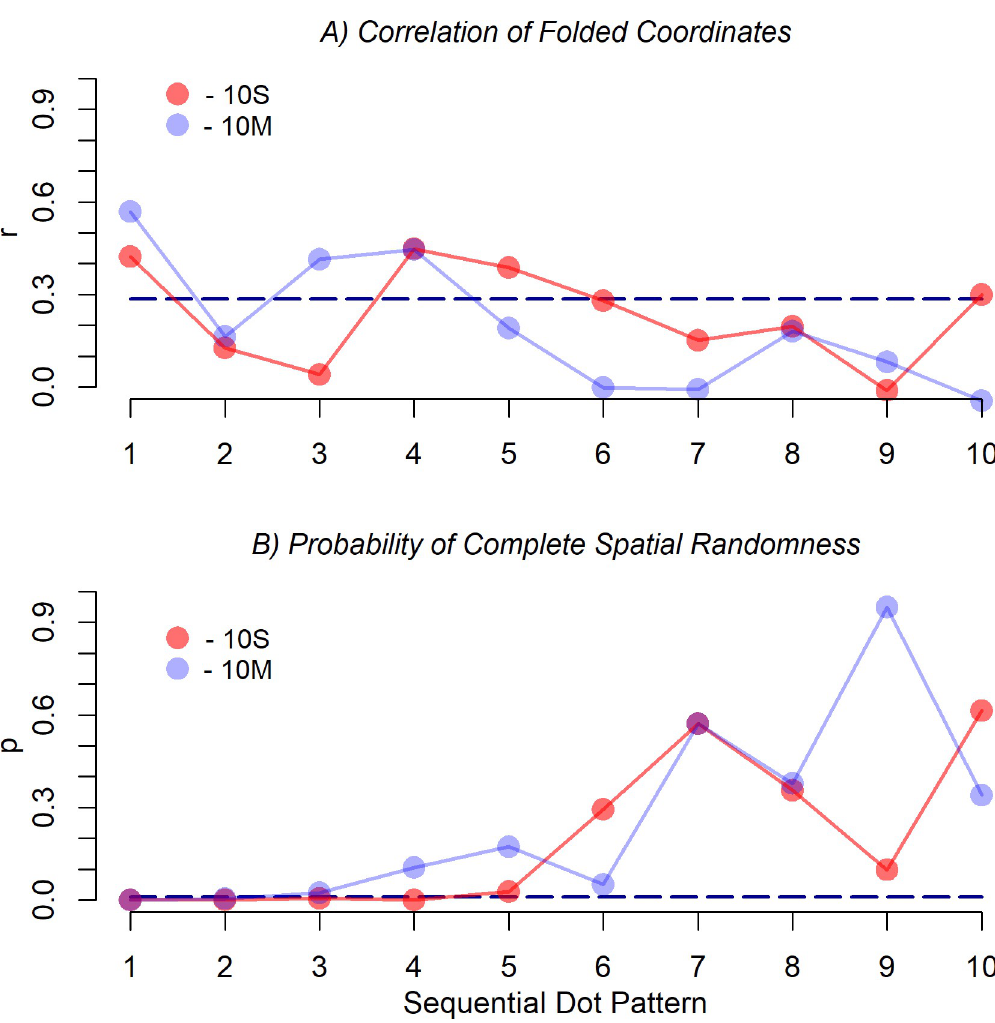
Fig 6. Correlations of the two-times folded coordinates (panel A ) and p -values of the quadrat (CSR) tests (panel B ) for the successive ten superimposed dot patterns in the two experimental conditions in Experiment 1. The dashed line in the upper panel indicates the critical value for a significance level of .05, i.e., values above this line are significant at this level. In the lower panel the dashed line indicates p =